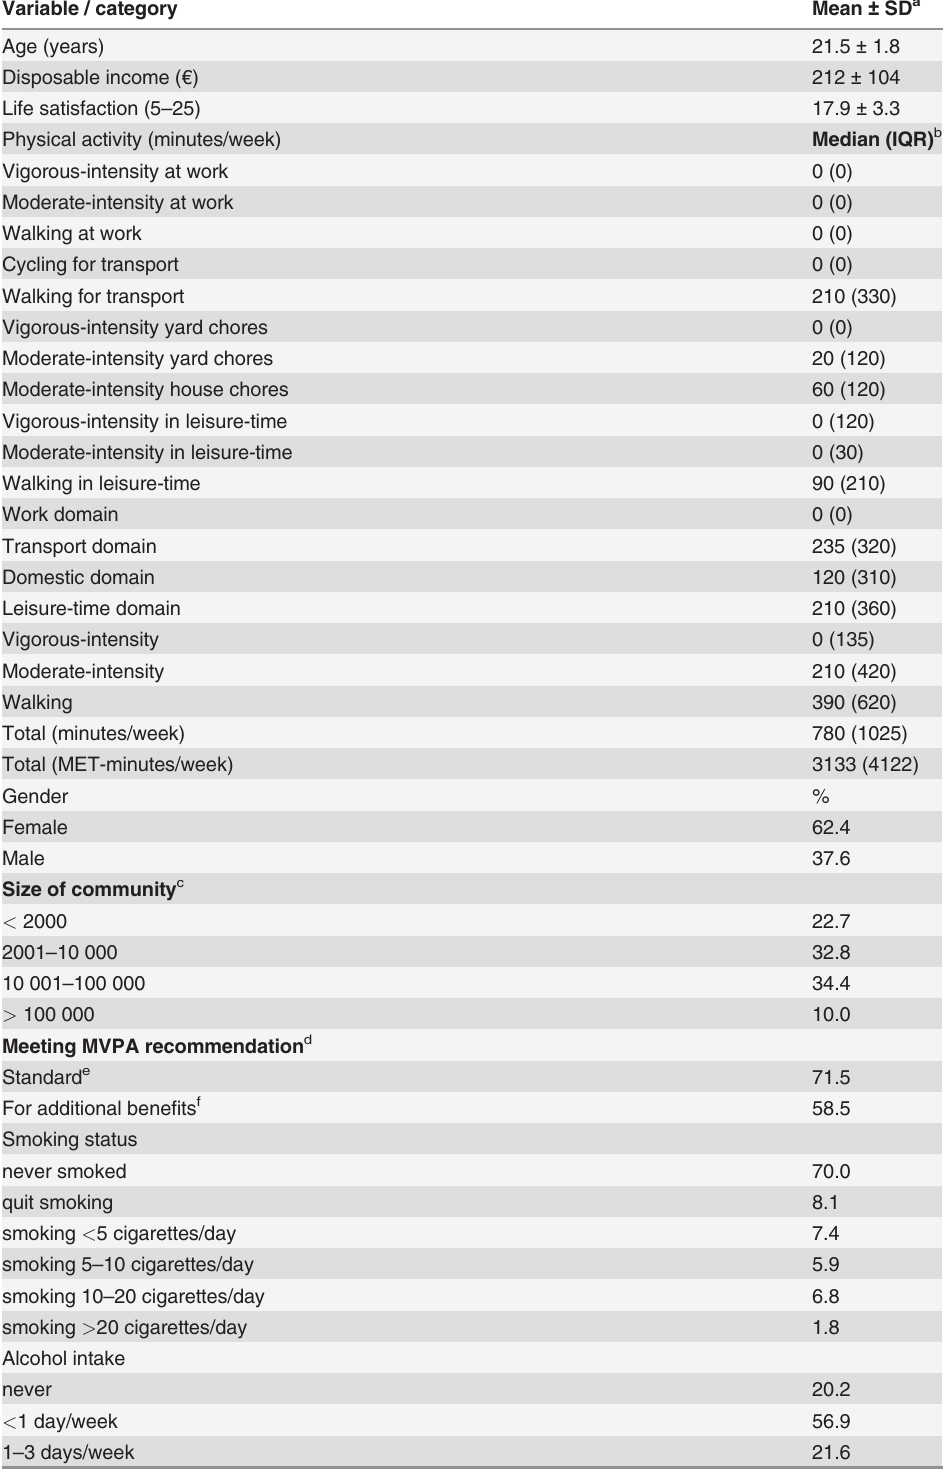
Table 1. Sample characteristics (n =